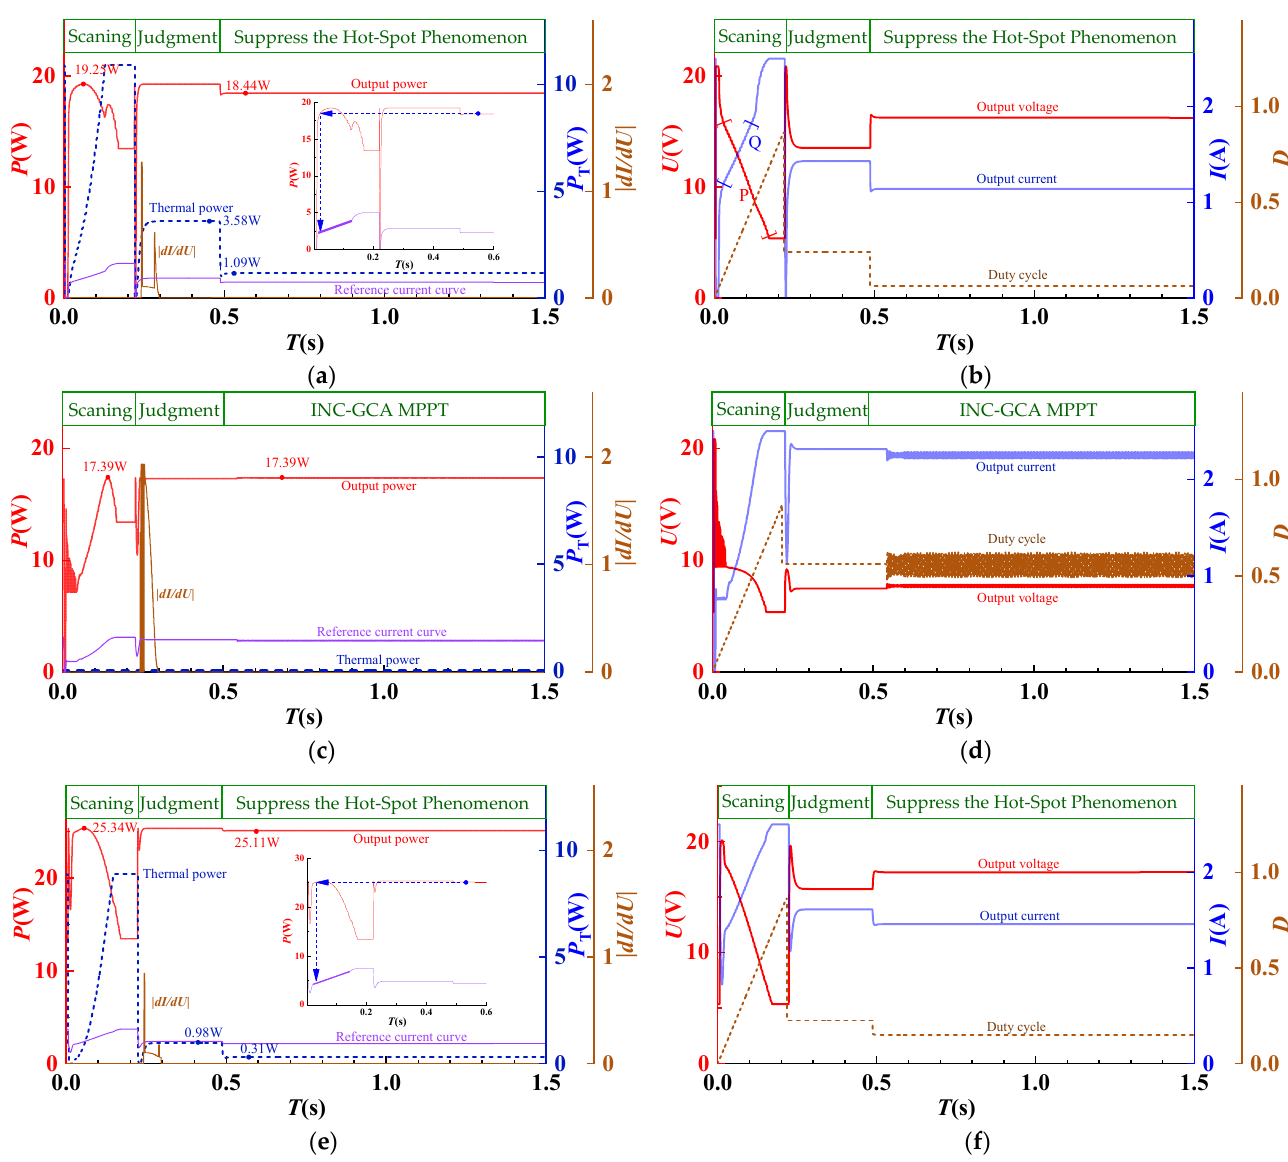
Figure 10. Simulation results of the algorithm on normal/faulty units under different β . ( a , b ) Hot-spot units ( β = 0.3); ( c , d ) Normal units ( β = 0.3); and ( e , f ) Hot-spot units ( β = 0.5).